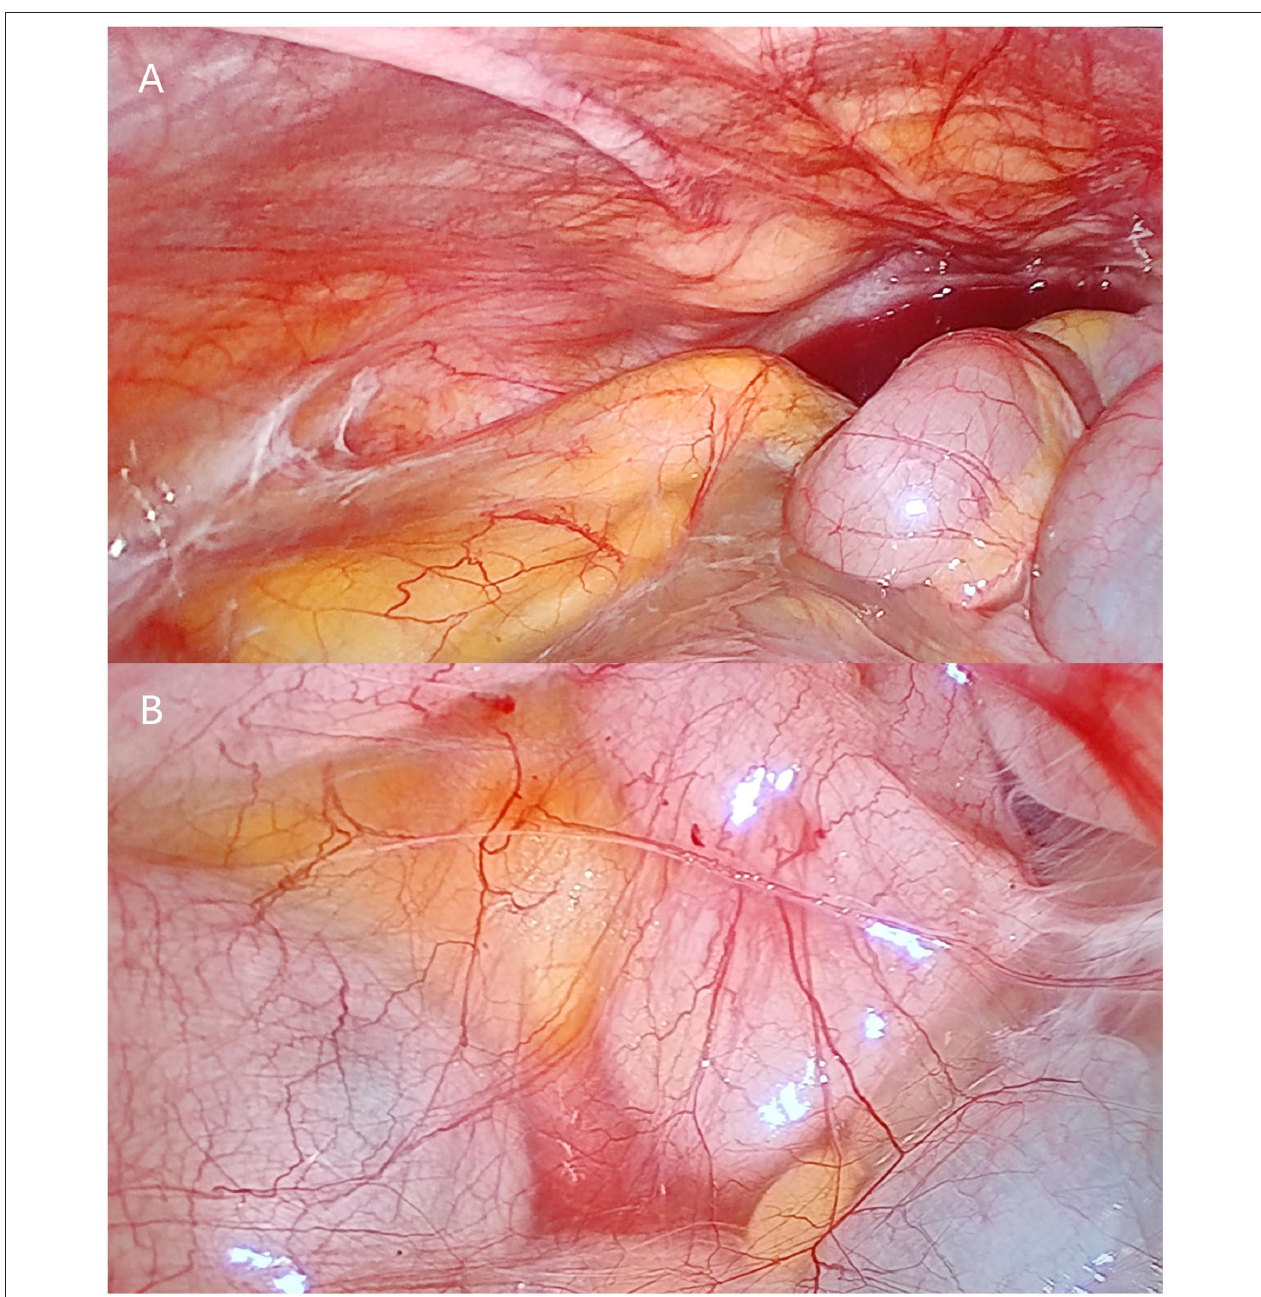
FIGURE 2 | Photographs of laparoscopic surgery. (A,B) show that the small intestine is surrounded by fibrous